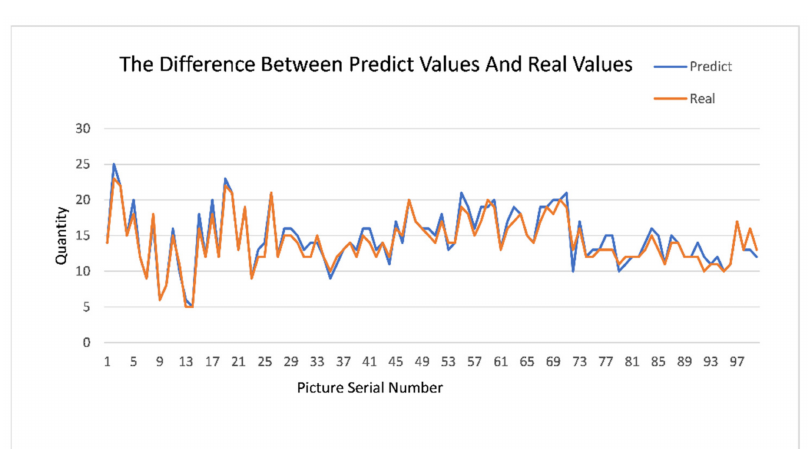
Figure 7. The loss of a valid dataset.